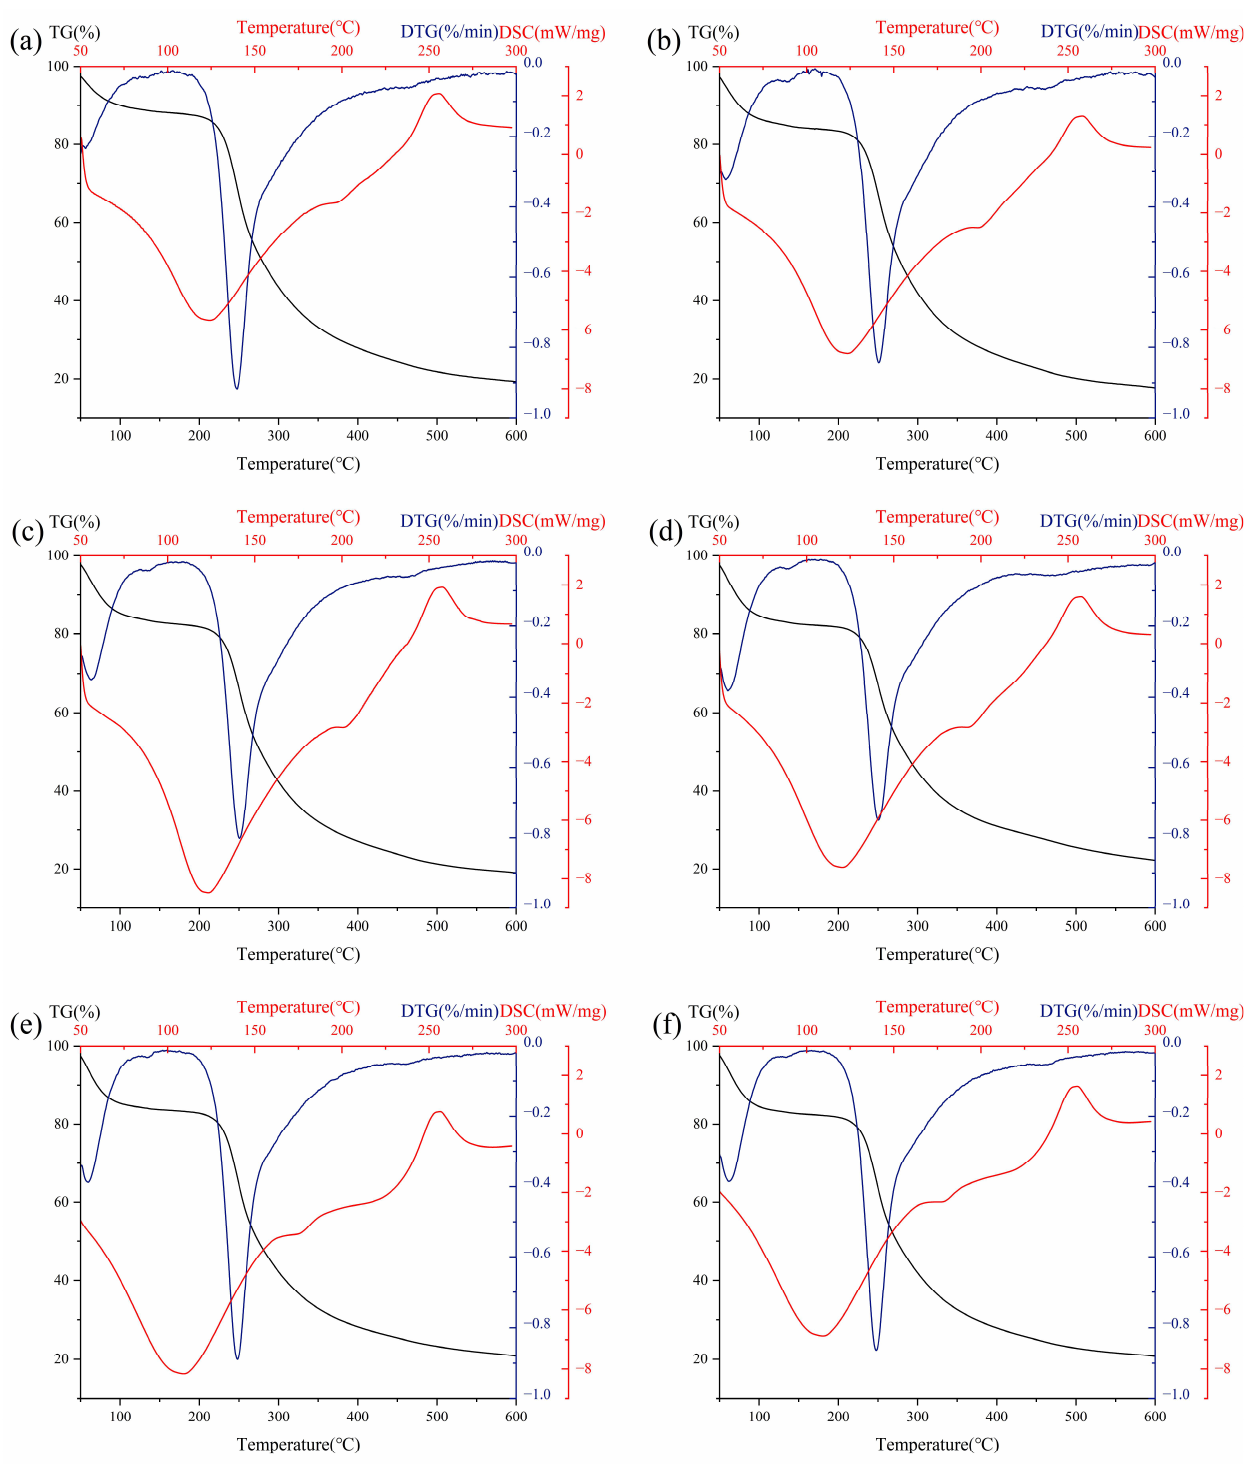
Figure 4. Thermal analysis of native SBP and its ultrasonic degradation products. ( a ) Native, ( b ) 10 min, ( c ) 20 min, ( d ) 30 min, ( e ) 60 min, ( f ) 90 min.